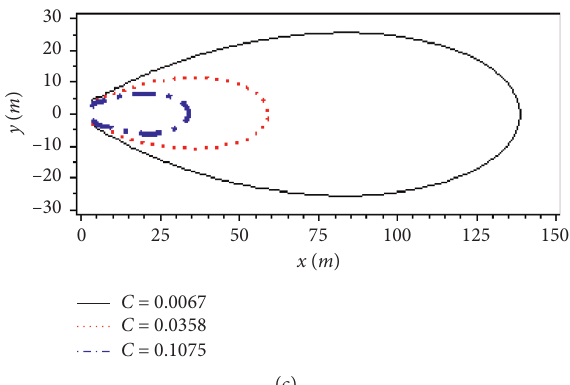
Figure 10: Concentration contours of continuous gas diffusion with different wind speeds ( Q � 173kg/s and atmospheric stability class is C).